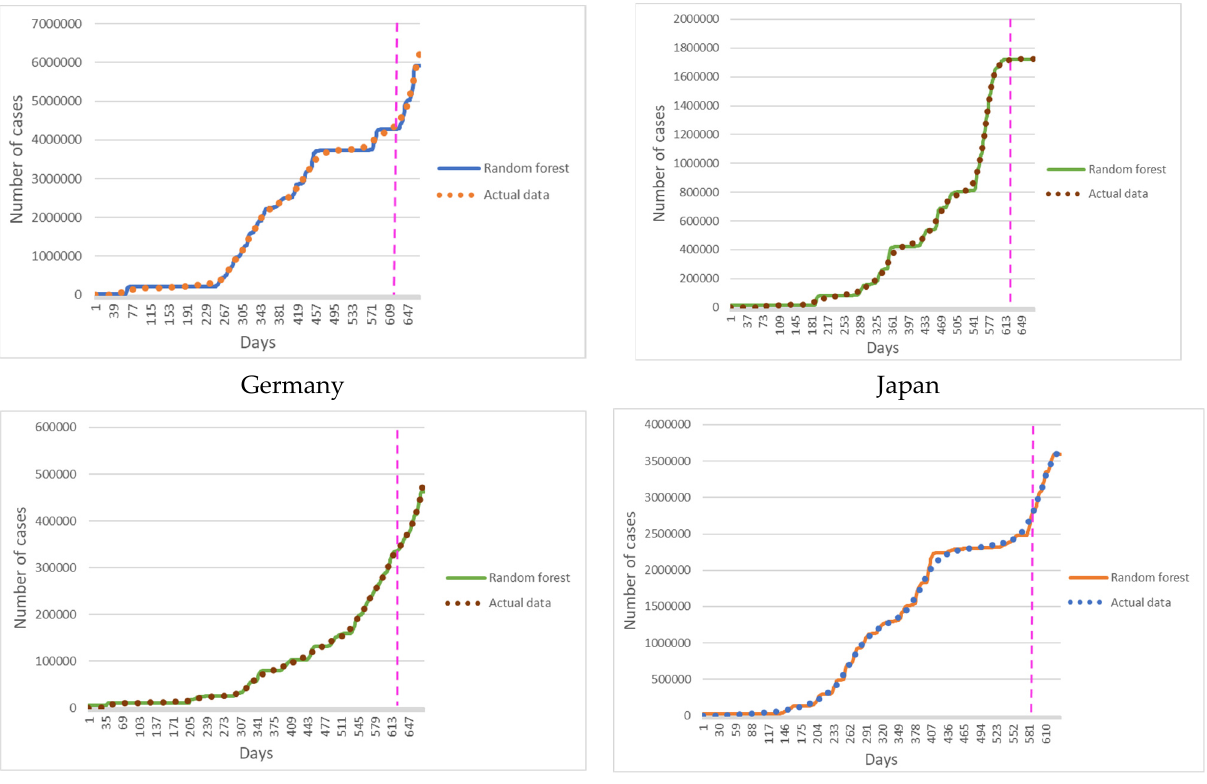
Figure 1. Forecasting of COVID-19 new cases by Random Forest model.